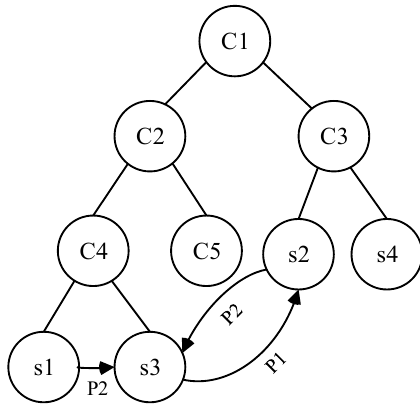
Figure 2. An example of service vectorization.